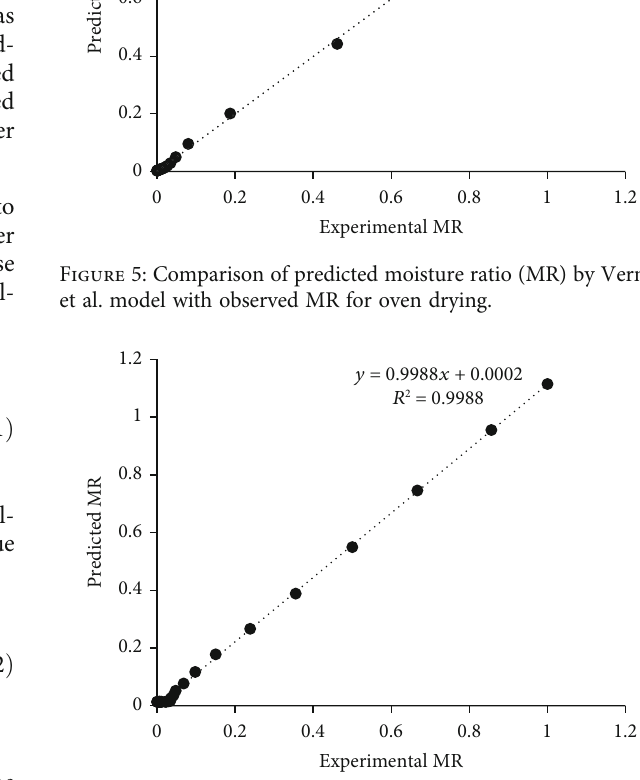
Figure 6: Comparison of predicted moisture ratio (MR) by the Hii et al. model with observed MR for solar drying.